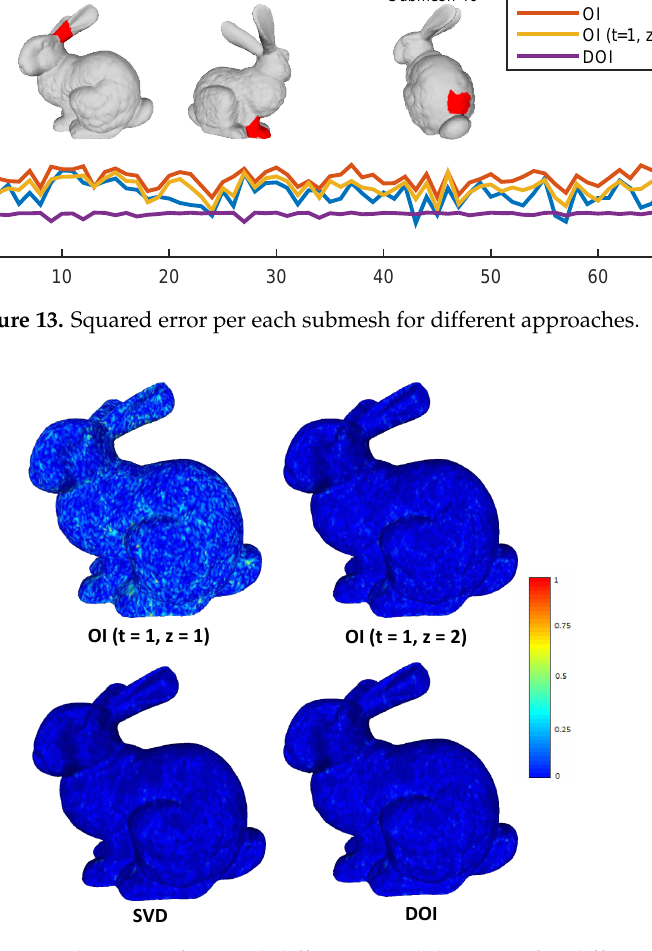
Figure 14. Heatmap visualazation of normal difference with bpv 5.64 for different reconstructed approaches.